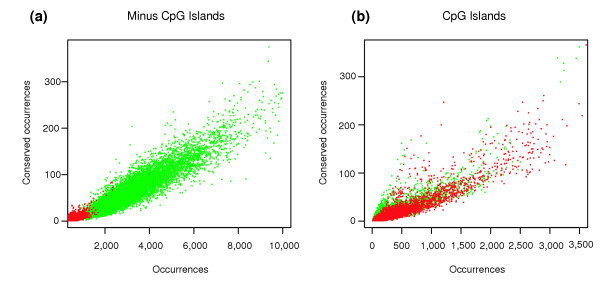
Two panels showing conservation versus occurrence of all 7-mer words upstream of genes split into (a) putatively unmethylated or (b) putatively methylated. In each case, only 5 kb upstream of genes was considered. Each word is colored either red if it has one or more CG dinucleotides or green otherwise.